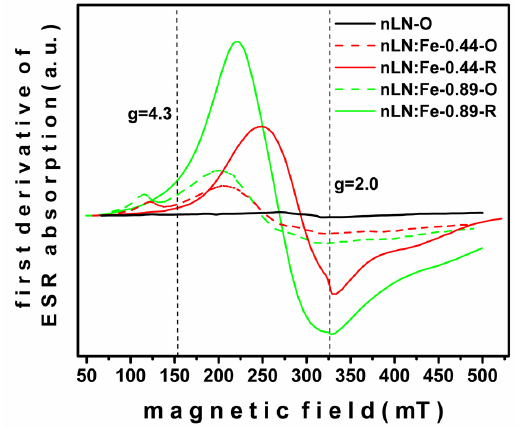
Figure 7. ESR spectra arising from different Fe-doped LN samples with varying doping concentration and two different post-thermal treatments.